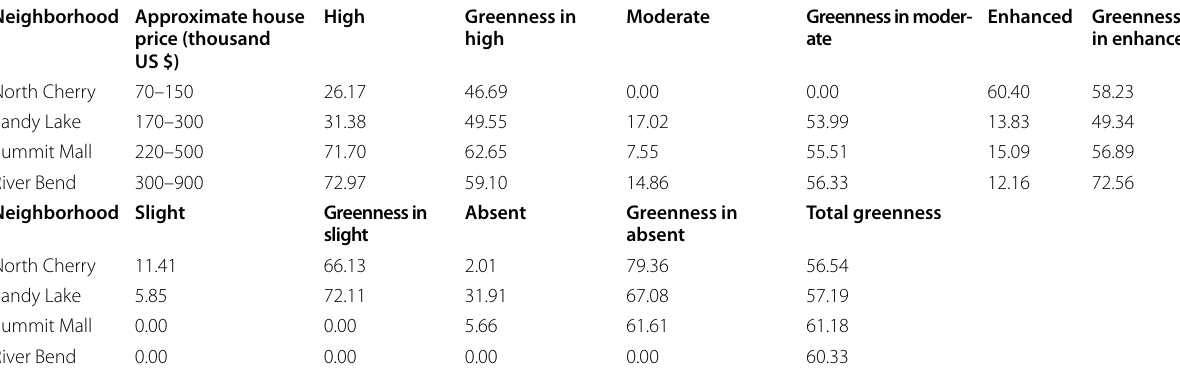
(a) high, denoting two-sided sidewalks the whole way; (b) denoting a street segment with two-sided and one-sided sidewalks; c) enhanced, denoting three variations in a street segment: two sides, one side, and no sidewalks; (d) slight, denoting a segment with one side and no sidewalks; and (e) absent, denoting no sidewalks in